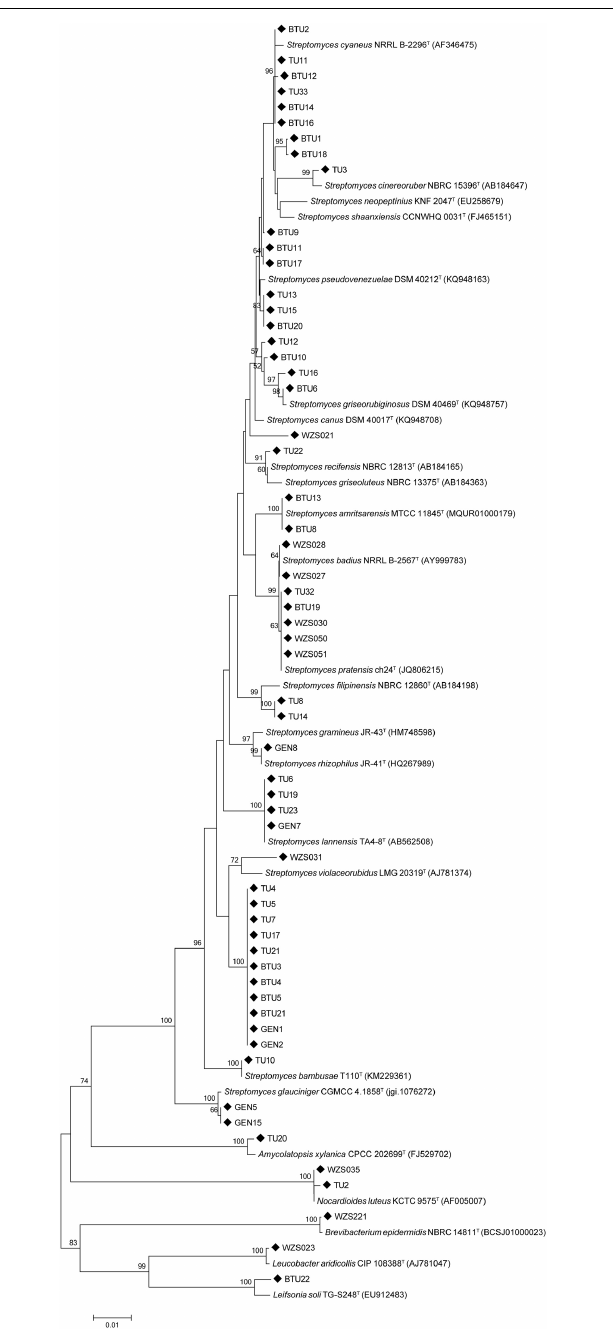
FIGURE 1 | The phylogenetic tree was constructed using the 16S rDNA sequence of sugarcane rhizosphere actinomycetes and similar type strains through the neighbor-joining